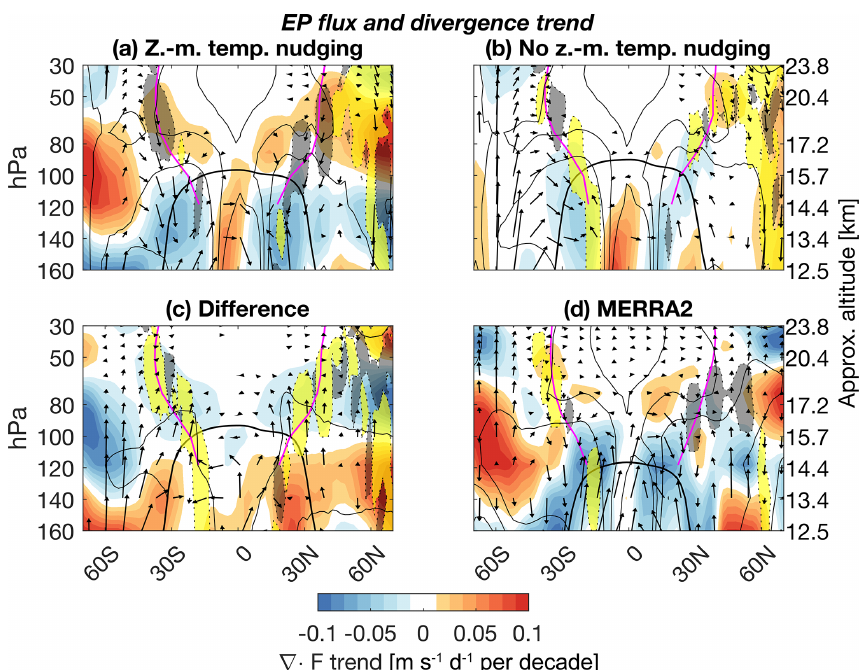
Figure 10. As in Fig. 9, but for the composites of simulations with (a) and without (b) zonal-mean temperature nudging, (c) the difference between the composites, and (d) MERRA2. Also shown are positive (yellow translucence) and negative (black translucence) changes in the index of refraction greater than 1 × 10 − 11 m − 2